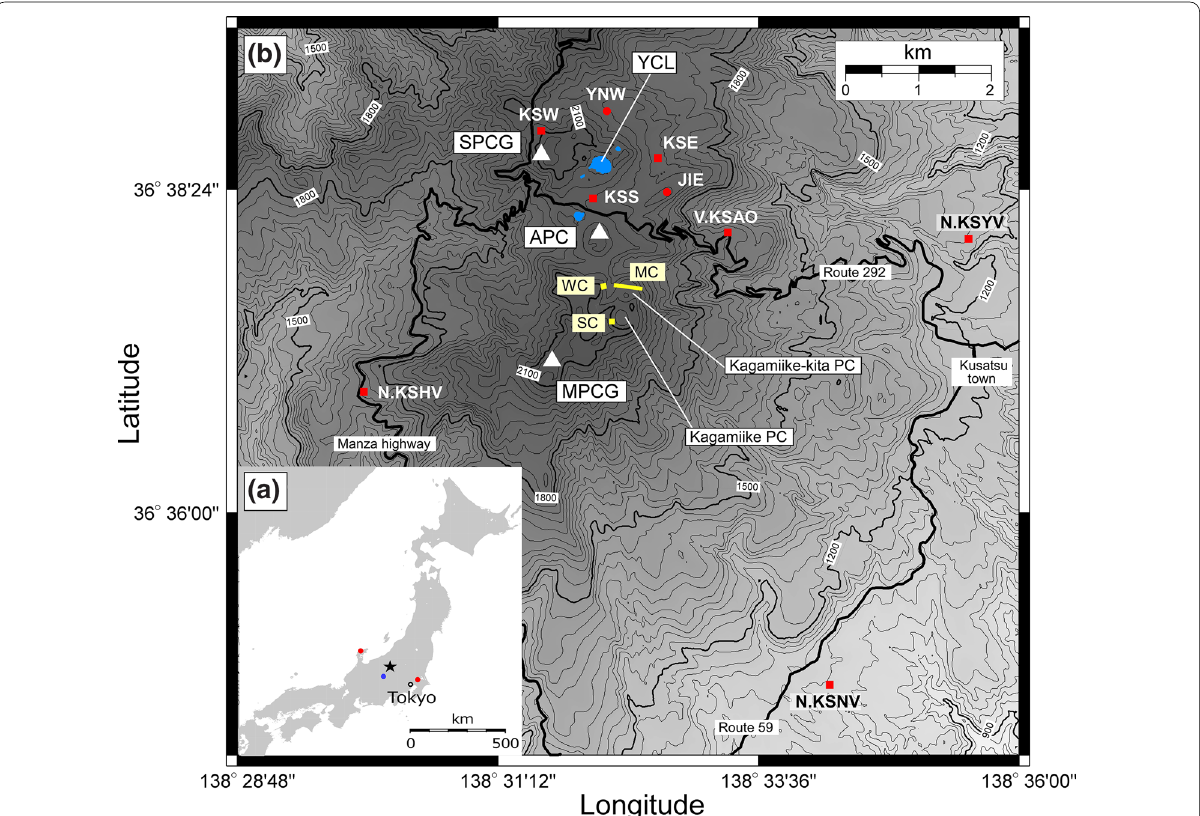
Fig. 1 Location and topography of Kusatsu–Shirane volcano. a Location map of Kusatsu–Shirane volcano in Japan (star). Blue and red circles represent the locations of the Nagano weather radar site and an aerological observatories using a balloon and radiosonde, respectively (both operated by the Japan Meteorological Agency). b Topographic map of Kusatsu–Shirane volcano. Solid lines are topographic contours at intervals of 30 m. Red squares and circles indicate the locations of tiltmeters installed at the bottom of boreholes and at a depth of 1–2 m from the ground surface, respectively (Table 1). Yellow squares (MC, WC, and SC) indicate the locations of craters that formed during the 2018 eruption. PC pyroclastic cone; MPCG Motoshirane Pyroclastic Cone Group; SPCG = = crater; WC west crater; SC south = =